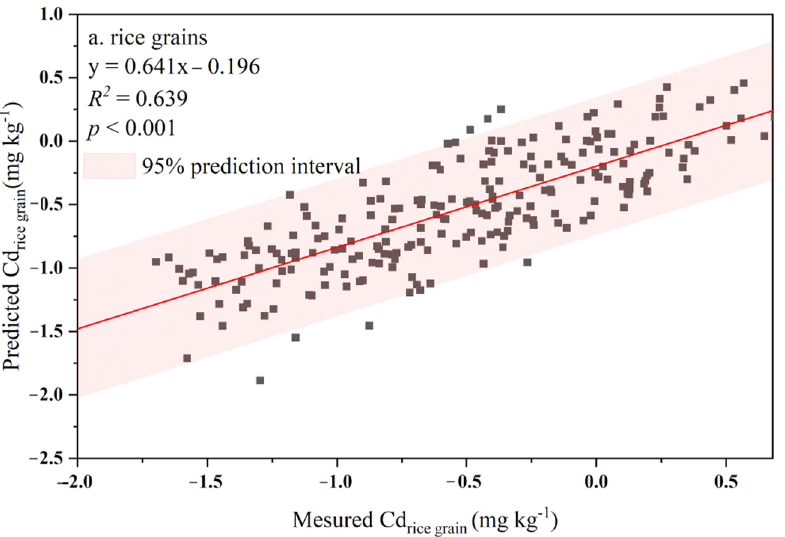
Figure 4. Relationships between Cd uptake by rice grains, soil Cd concentrations, and soil pH.